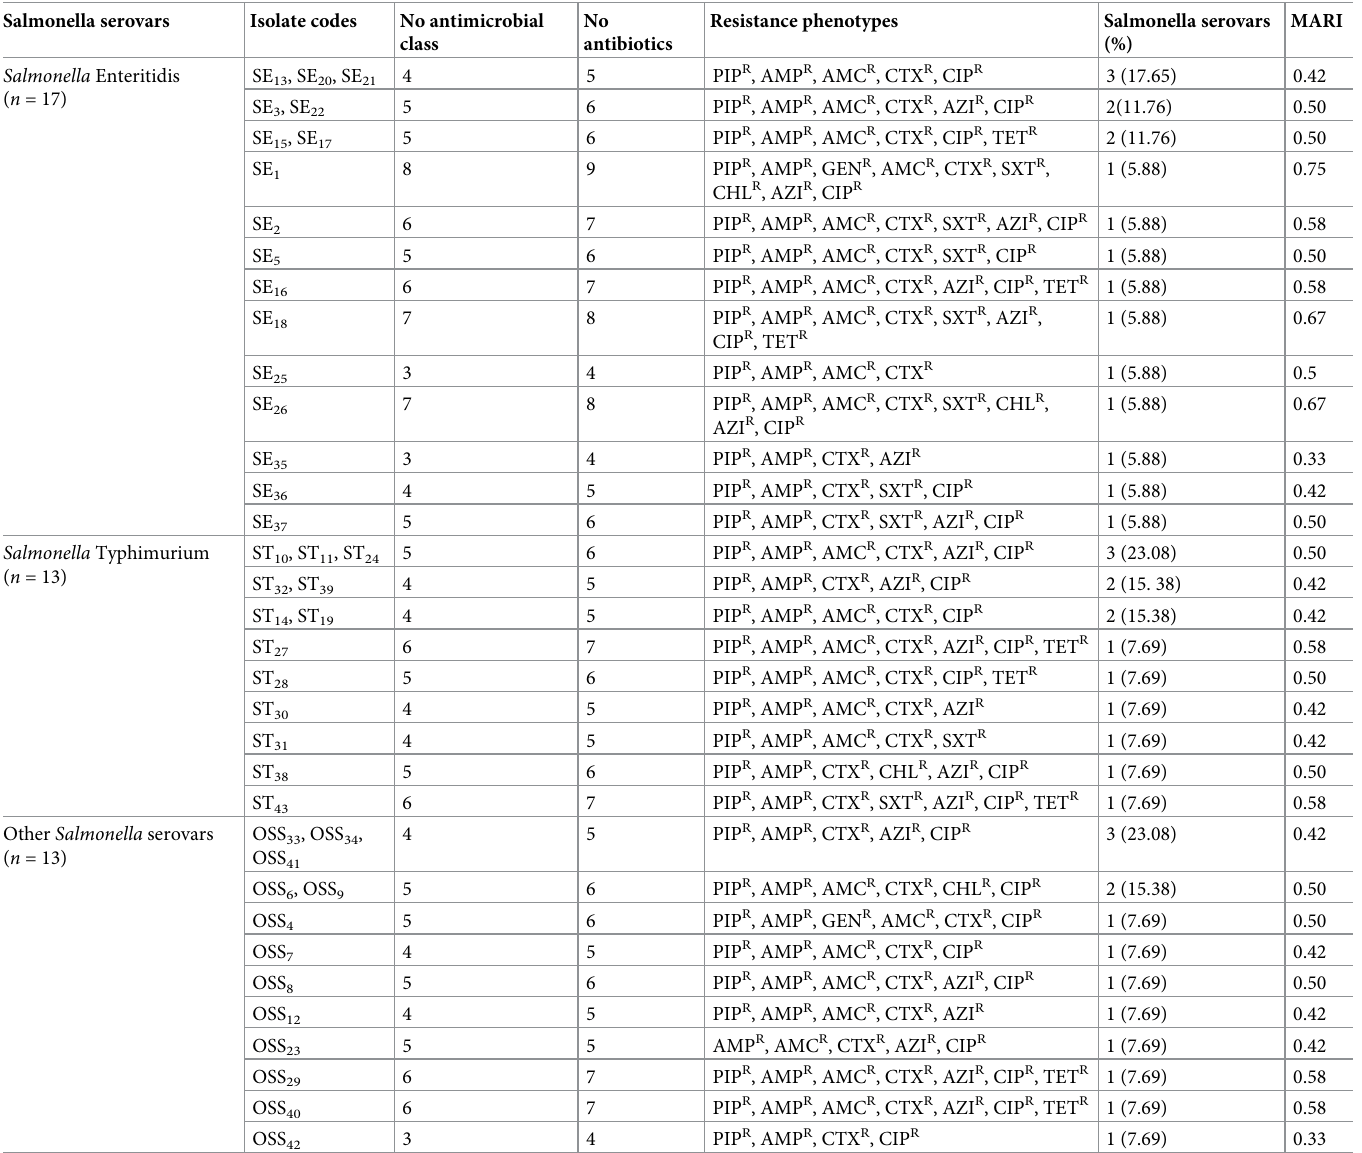
Table 3. Multiple antibiotics-resistant distribution of the Salmonella isolates. Salmonella serovars Isolate